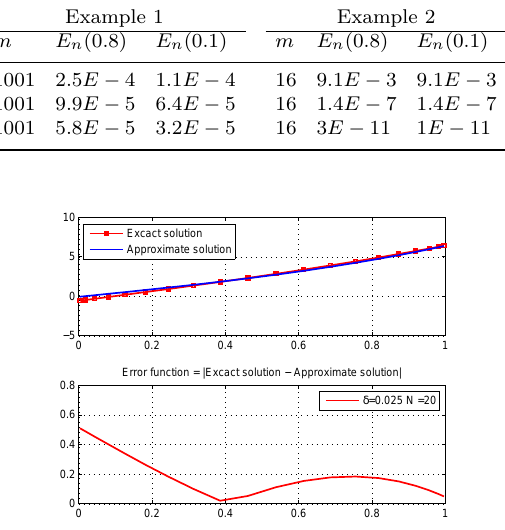
with the exact solution x + ( t ) = 11 which means v =